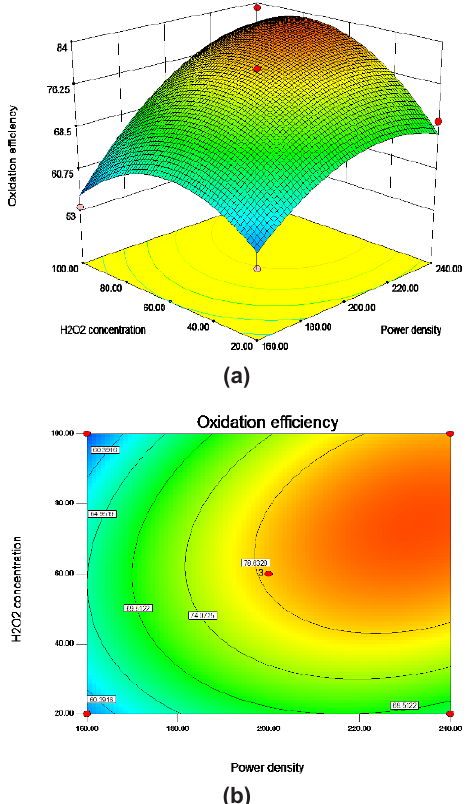
Figure 7. Effect of power density and H O concentration on the 2 2 O arsenite oxidation efficiency with the initial concentration 2 2 of arsenite at the zero level: (a) response surface and (b) contour plot of the predicted oxidation